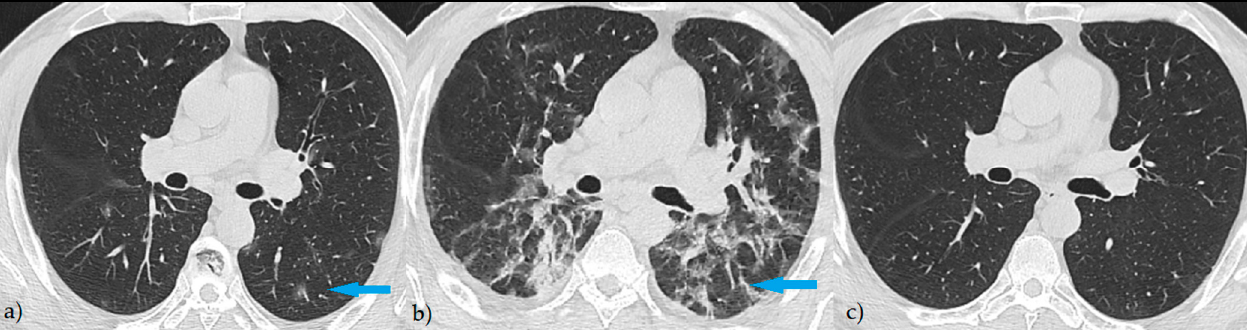
Figure 2. HRCT pattern of complete remission—Axial HRCT images: ( a ) minimal focal areas of GGO at the onset of the symptoms (blue arrow); ( b ) consolidation with a reticular pattern at 14 days from diagnostic (blue arrow); ( c ) complete remission of the lesions at 3 months.